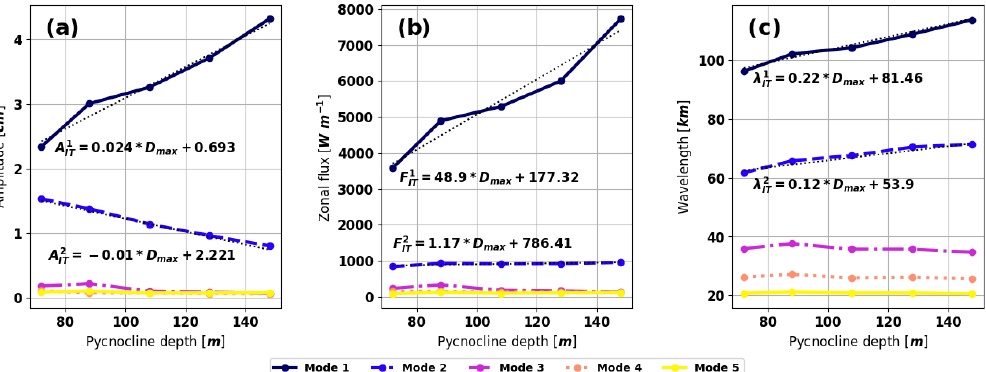
Figure 6. (a) Surface elevation amplitude, (b) vertically integrated zonal energy flux and (c) horizontal surface wavelength for each vertical mode with respect to the pycnocline depth. The calculations are based on the western equatorial Atlantic simulations over the abyssal domain ( − 300km <x < 200km). The fit equations for the two first modes are shown below the curves (with A n λ n the IT surface wavelength for mode n and D max the pycnocline IT